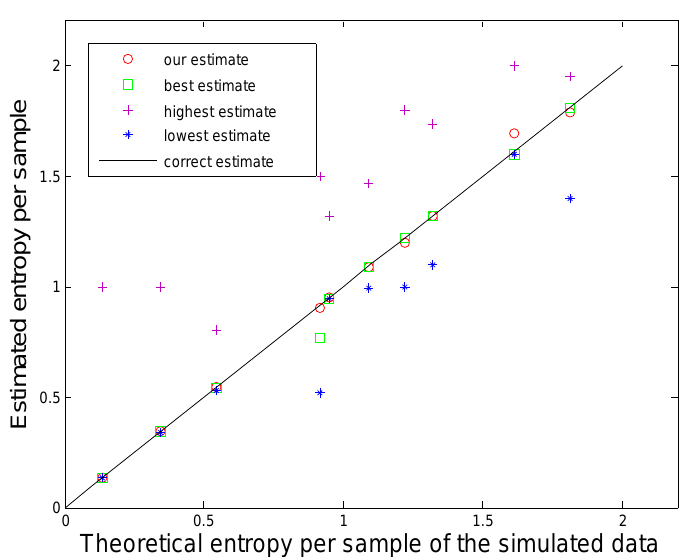
Figure 4: The comparison between our estimator and NIST estimation suite using data from Markov model